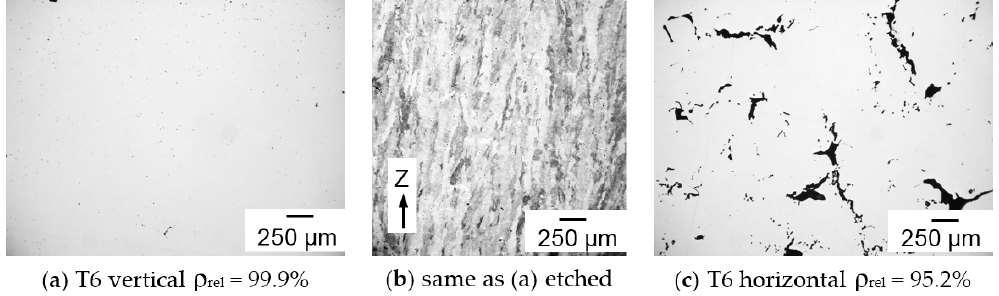
Figure 4. Polished cross sections: ( a ) vertical sample: very small round pores (black); ( b ) the same sample as in (a), but etched—directional grain structure; ( c ) horizontal sample—large irregular voids (black).